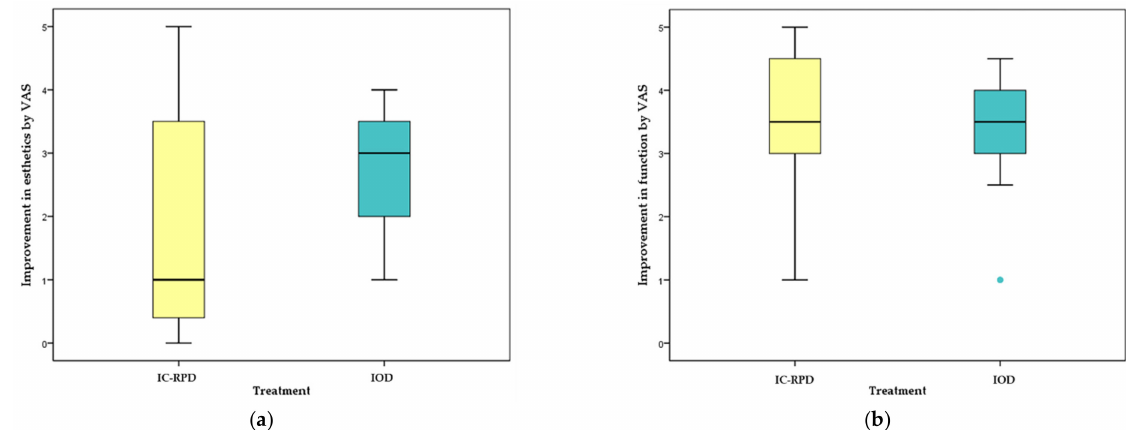
Figure 7. Esthetic and functional improvement by VAS according to treatment modality (IC-RPD vs. IOD). ( a ) Esthetic satisfaction showed significantly different results according to treatment modality; the IOD group showed statistically higher measured values ( p = 0.041). ( b ) Functional improvement showed no differences ( p > 0.05) between groups. Green dot indicated only one patient with VAS value of 1 after delivery of